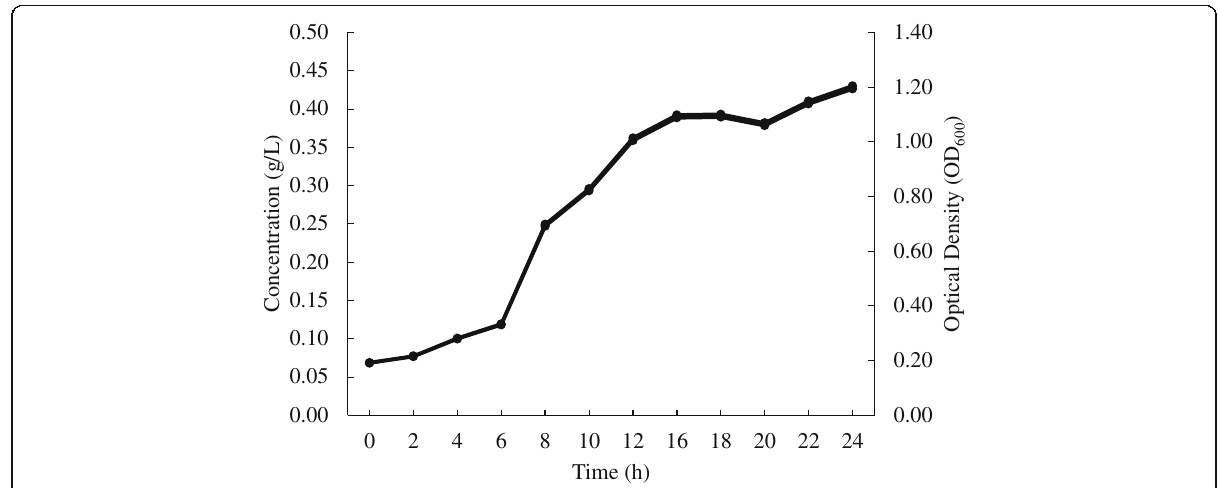
Fig. 2 Growth of Lactobacillus brevis measured as concentration (g/L) and optical density (OD 600 ) using MRS media